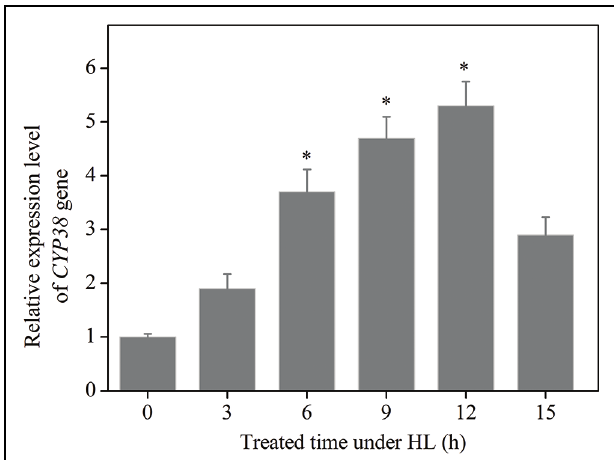
FIGURE 2 | Changes in CYP38 gene expression in HL treated WT Arabidopsis plants. qRT-PCR analysis of the expression of CYP38 gene during 15 h in the HL-treated WT plants. After HL treatment, total RNAs were extracted from the HL-treated plants at indicated times. Error bars are ± SD values for three replicates. Asterisks ( ∗ ) indicate a significant difference from the control at ∗ P < 0.05.